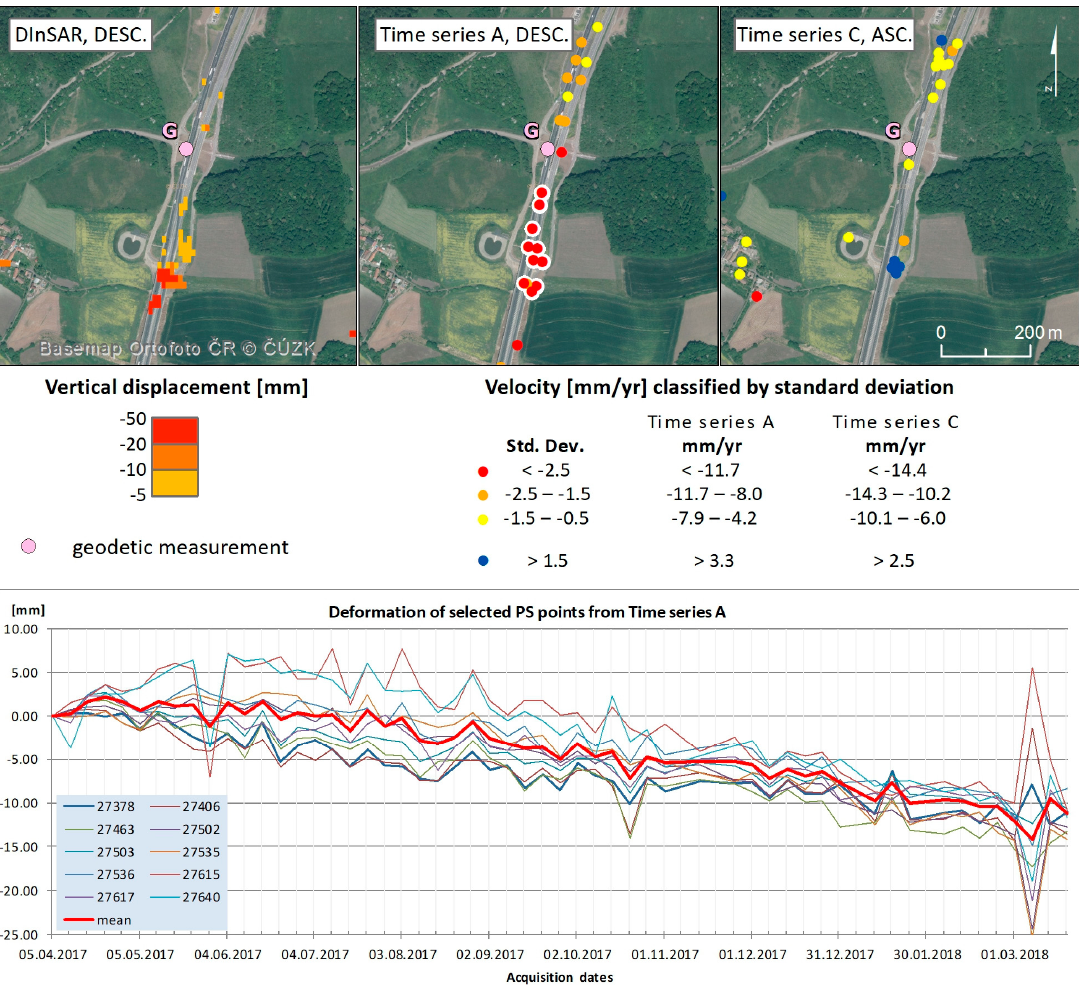
Figure 15: Figure 13. Combined outcomes of the methods used for detecting land subsidence / uplift in area No. 1. From the left: the single-pair DInSAR and the PSI results (time series A and C), and a graph of the deformation of selected PS points from time series A, highlighted with white background on